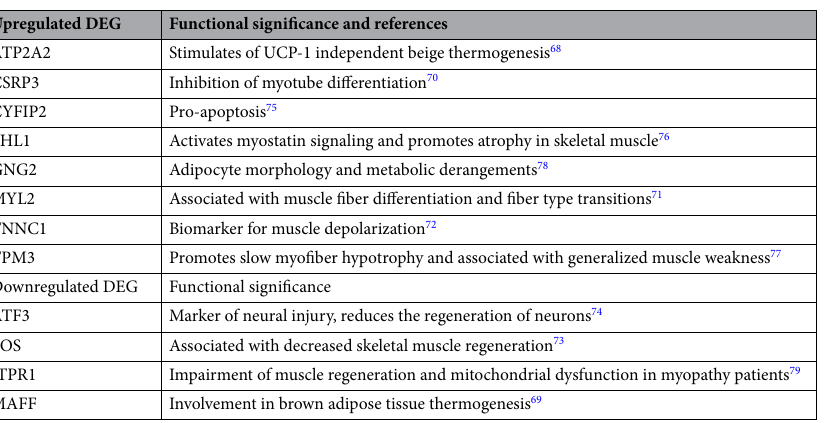
Table 4. Muscle ingenuity analysis of canonical signaling p thways in wild type CKD mice versus wild type control mice. We focus on pathways related to energy metabolism, skeletal and muscular system development and function, nervous system development and function as well as organismal injury and abnormalities. Functional significance of those differentially expressed genes are